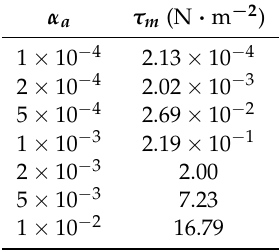
Table 3. Calculated torque densities at different particle concentrations at the fluid strain rate ˙ γ b = 500s − 1 . The torque densities were computed from Equation (22), where each particle chain’s torque was calculated by Equation (14). The particle chain length distributions at the different concentrations were determined based on the micro-domain